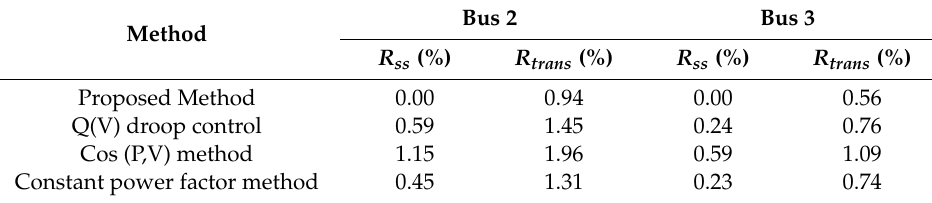
Figure 14. Comparison results for voltage responses of buses 2 ( a,c ) and 3 ( b,d ). Table 9. Comparison of voltage variations when PV2, PV3 and PV4 are disconnected.